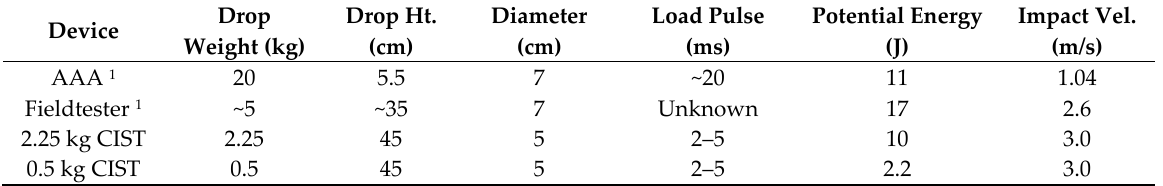
Figure 2. ( a ) the Fieldtester showing the readout unit (left) and in profile (right) (reproduced from [3]); ( b ) the Clegg Impact Soil Tester (2.25 kg unit) and guide tube with the readout unit attached. Table 1. A comparison of the “hardness” test methods, their impact energy and impact